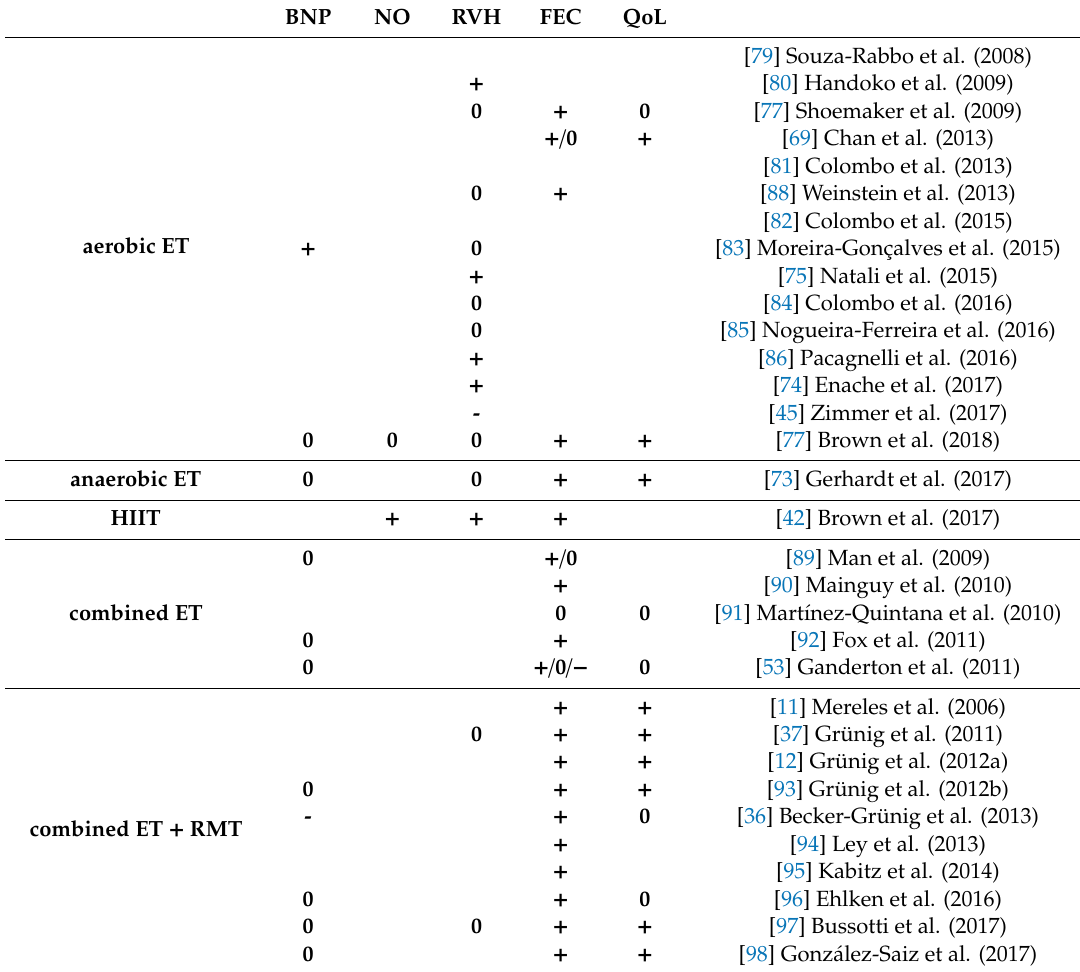
Table 10. Summary of e ff ects on cellular, molecular, physiological, and psychological factors in correlation with di ff erent types of ET (negative ( − ), neutral (0), or positive ( +